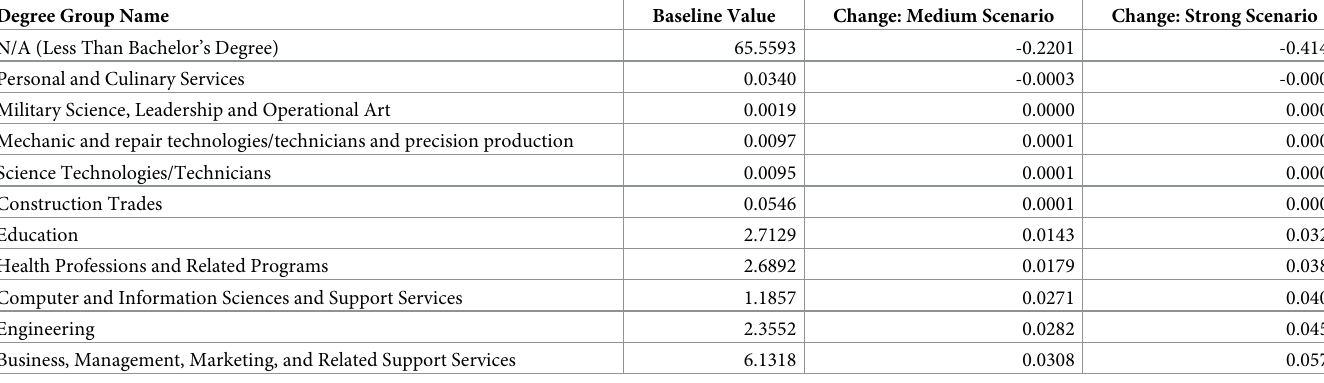
Table 7. Projected changes in percent of workforce holding each degree group (shown as a